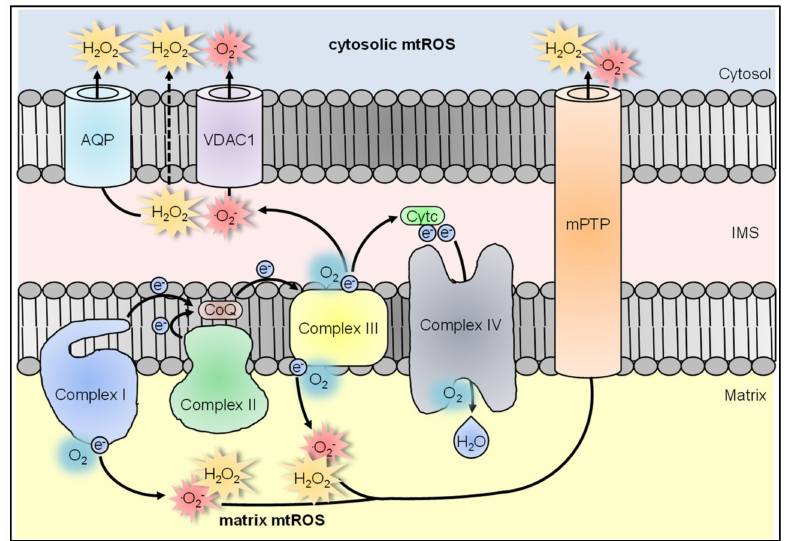
Figure 4. Electrons are shuttled from NADH and FADH 2 through the four complexes I-IV of the electron transport chain (ETC) and the electron carriers coenzyme Q (CoQ) and cytochrome c (Cyt c). Mitochondria generate ROS mainly through complexes I and III. Matrix-derived O 2 •− and H 2 O 2 can only reach the cytosol after mitochondrial permeability transition pore (mPTP) opening or damage caused to mitochondrial membranes. From the intermembrane space (IMS), H 2 O 2 can reach the cytosol through diffusion or aquaporins (AQP), whereas O 2 •− can cross the outer mitochondrial membrane only through membrane channels such as voltage-dependent anion channels